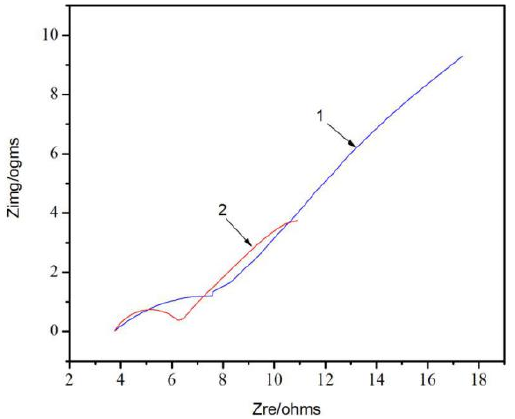
Figure 5. Impedance curve of copper surface before and after brush plating. (Curve 1: pure copper sheet; Curve 2: tin plating layer).